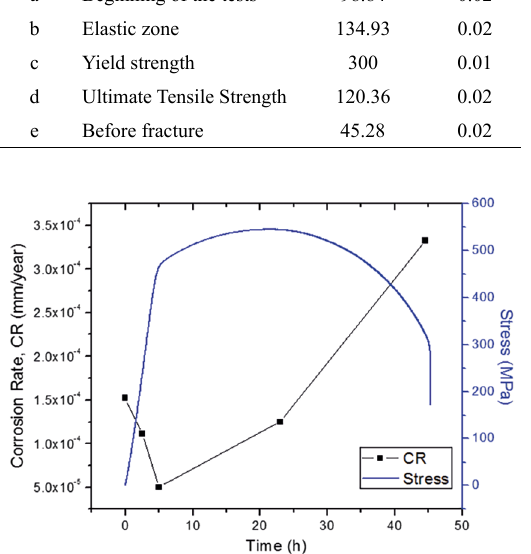
Figure 9. Stress-time profile and CR as a function of the time. CR was obtained by Rn in NS4 solution with pH 8. Five conditions where used: beginning of the test, elastic zone, YS, UTS and before of the fracture.